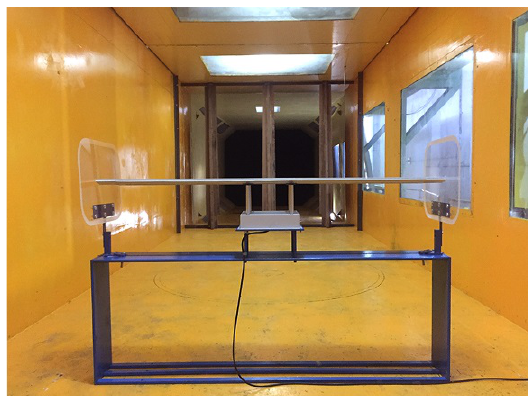
Figure 10. Aerodynamic admittance function identification test.